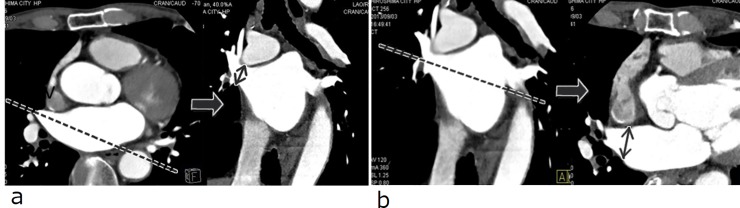
Identification and labeling of the right superior pulmonary vein (RSPV) ostia in two-dimensional viewing.(a) Measurement of superoinferior diameter of RSPV ostium (solid arrow). (b) Measurement of anteroposterior diameter of RSPV ostium (solid arrow).